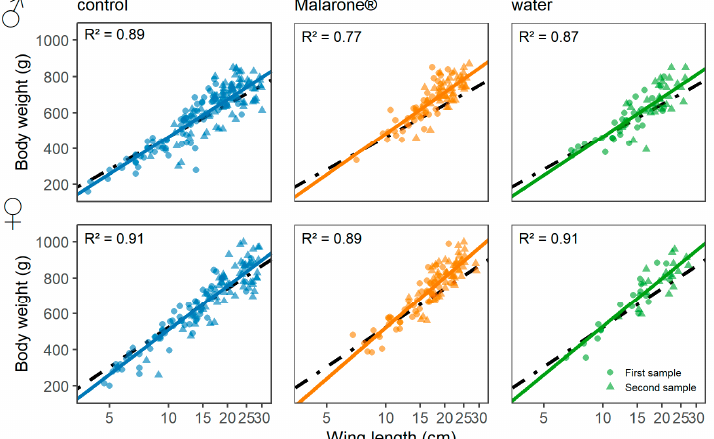
Figure 2. Regression analyses for weight and wing length. Visualisation of regression analyses for weight and wing length of control, Malarone ® -, and water-treated nestlings (solid line) in comparison to the reference data of common buzzards [20] (dotted black line) for female ( ♀, n = 136) and male ( ♂, n = 163) individuals. Circles represent values at first sampling, triangles at second sampling. R 2 represents the proportion of variance explained by both fixed and random effects in each model.